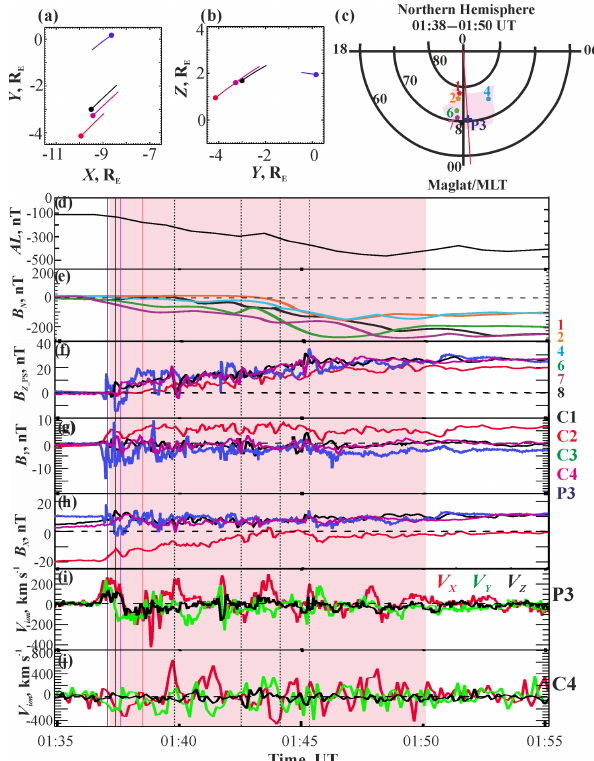
Figure 1. An overview of the dipolarization event observed on 20 July 2013. Panels (a) and (b) show the positions of the Cluster spacecraft and the THEMIS P3 probe in the near-Earth PS during the interval of interest in the (XY) GSM and (XZ) GSM planes. Fig- ure 1c shows the ionospheric footpoint of the P3 probe (marked by the blue crest) and the locations of the nearest ground magnetic sta- tions indicated by the colored dots with the corresponding numbers (for the description of stations, see Table 1). The region of ground magnetic perturbation is shaded pink. Panels (d) and (e) display the time profiles of the AL index and the ground magnetic field component B N measured by the stations located near the P3 probe ionospheric footpoint respectively. Panels (f–h) show three GSM components of the PS magnetic field ( B Z _PS , B Y _PS and B X _PS ) observed by Cluster and the P3 probe. Panels (i) and (j) display three components of ion bulk velocity observed by the P3 probe and C4 respectively. The moments of onset-related DF observed by the P3 probe and C1, C4 and C2 are shown by solid vertical lines of blue, black, magenta and red color, respectively. The interval of dipolarization growth is shaded pink. Vertical dotted lines mark the B Z pulses for which the estimation of spatial scales was made (see explanations in Sect. 6).